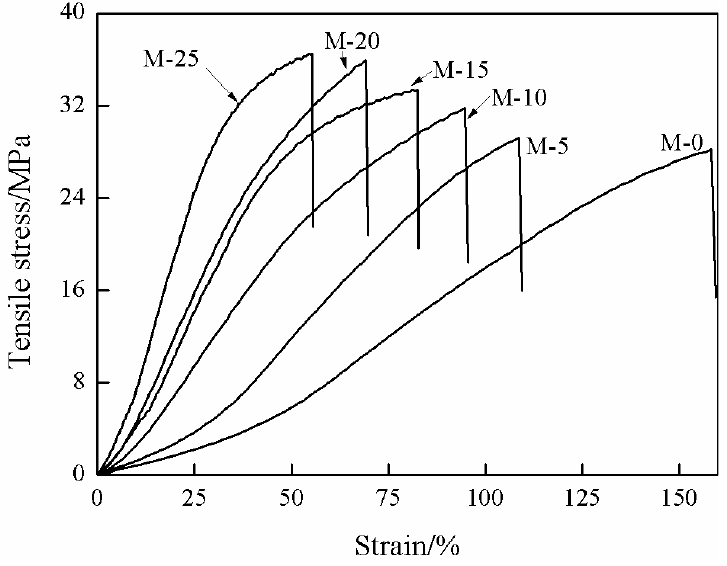
Figure 6. Mechanical properties of the mixed matrix membranes.